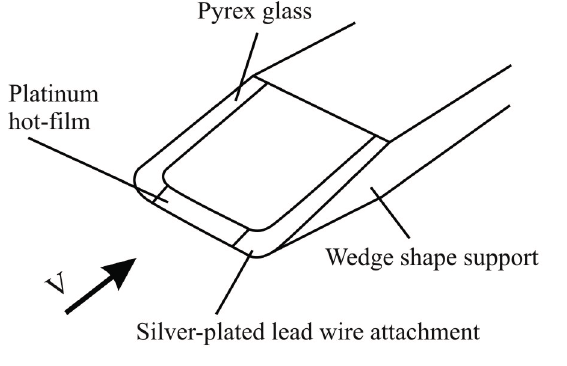
Figure 5. Wedge thin-film thermo-anemometer diagram